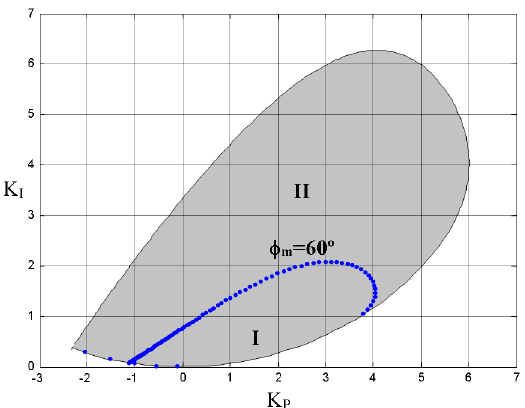
(4) Table 1. Stability regions on the controller parameter plane. Control